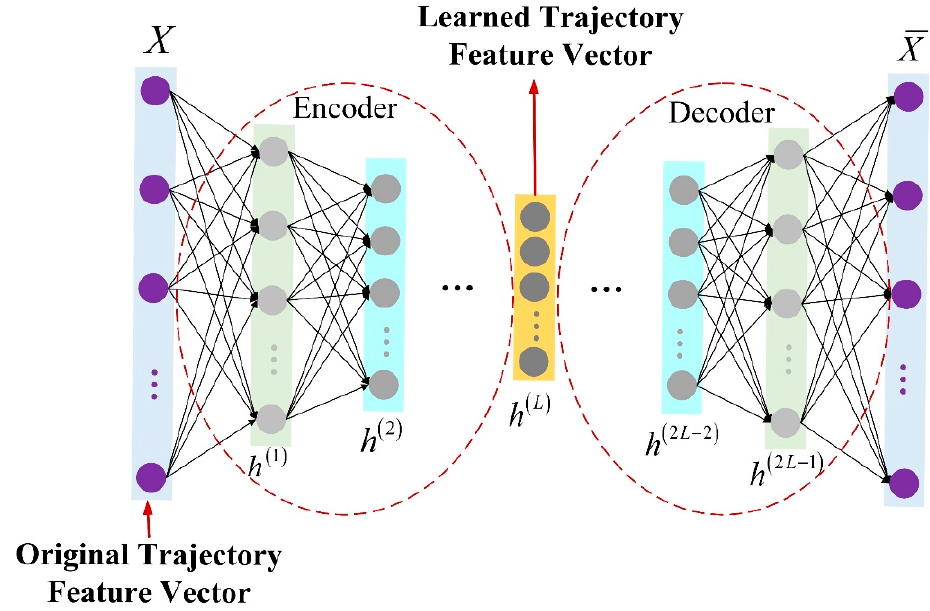
Figure 4. Schematic diagram of the network structure of the stacked autoencoder.